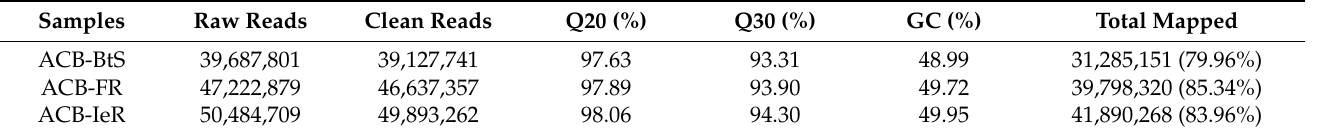
Table 2. Summary of average reads in transcriptomes of ACB-FR, ACB-IeR and susceptible (ACB- BtS)